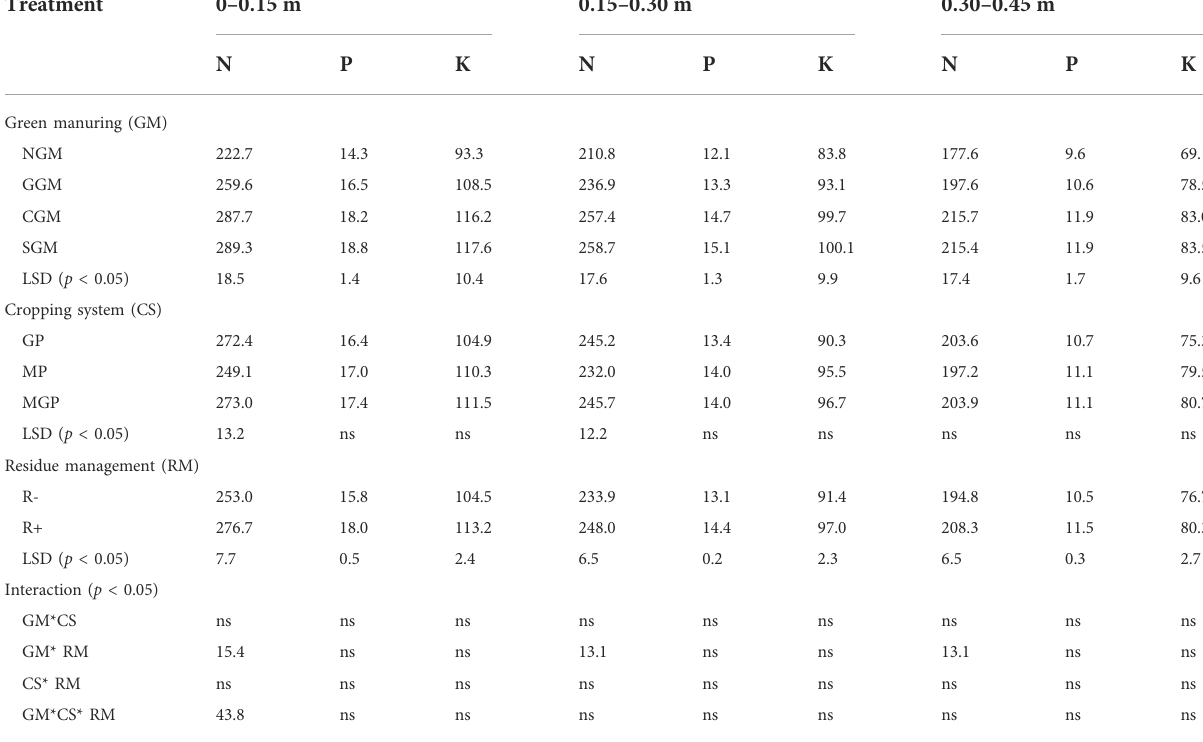
TABLE2Effect ofgreenmanuring,croppingsystems, andresiduemanagementonthe nutrientstorageofavailableN,P,andKindifferent soildepths after 5 years of experimentation.